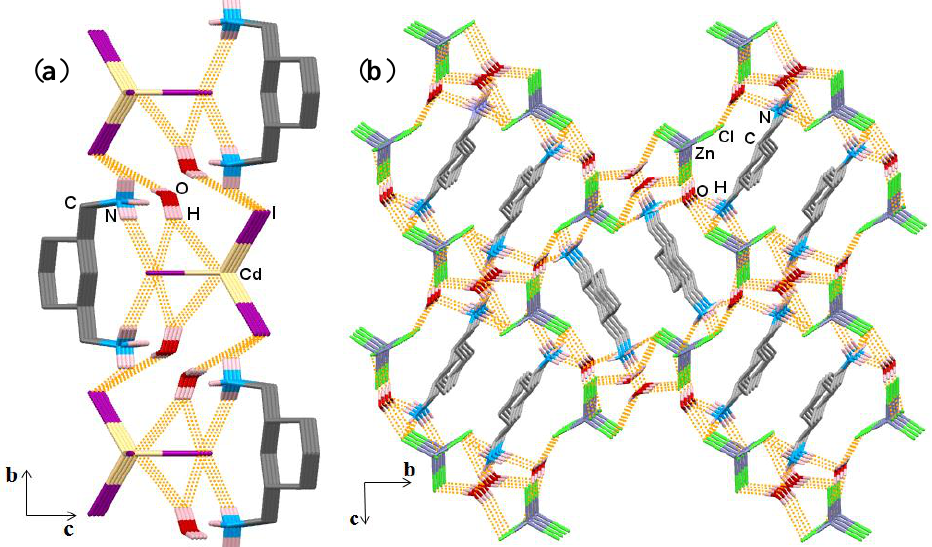
Figure 4. Depending on the orientation of the ammonium groups of the (CHBMAH 2 ) 2+ , two assembling patterns have been observed, ( a ) two-dimensional (2-D) in 3 (upward orientation) and ( b ) three-dimensional (3-D) in 2 (downward orientation) H-bonded